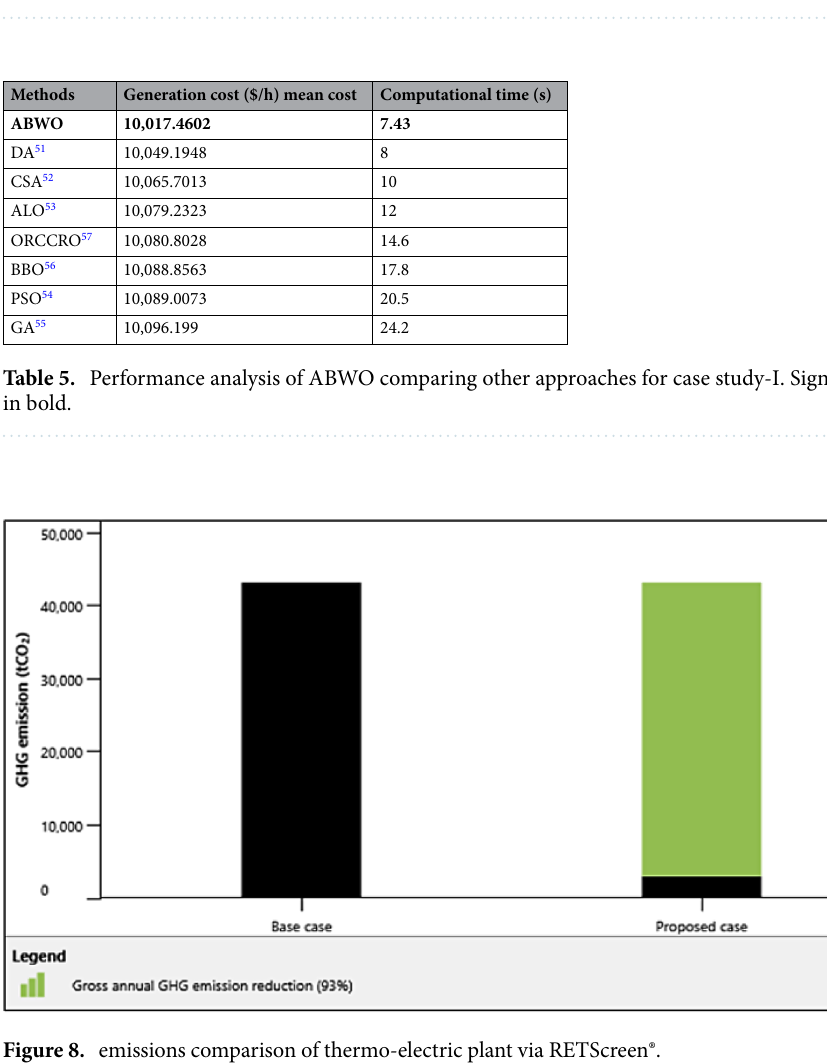
Table 4. Thermal units cost input data for case study-I.